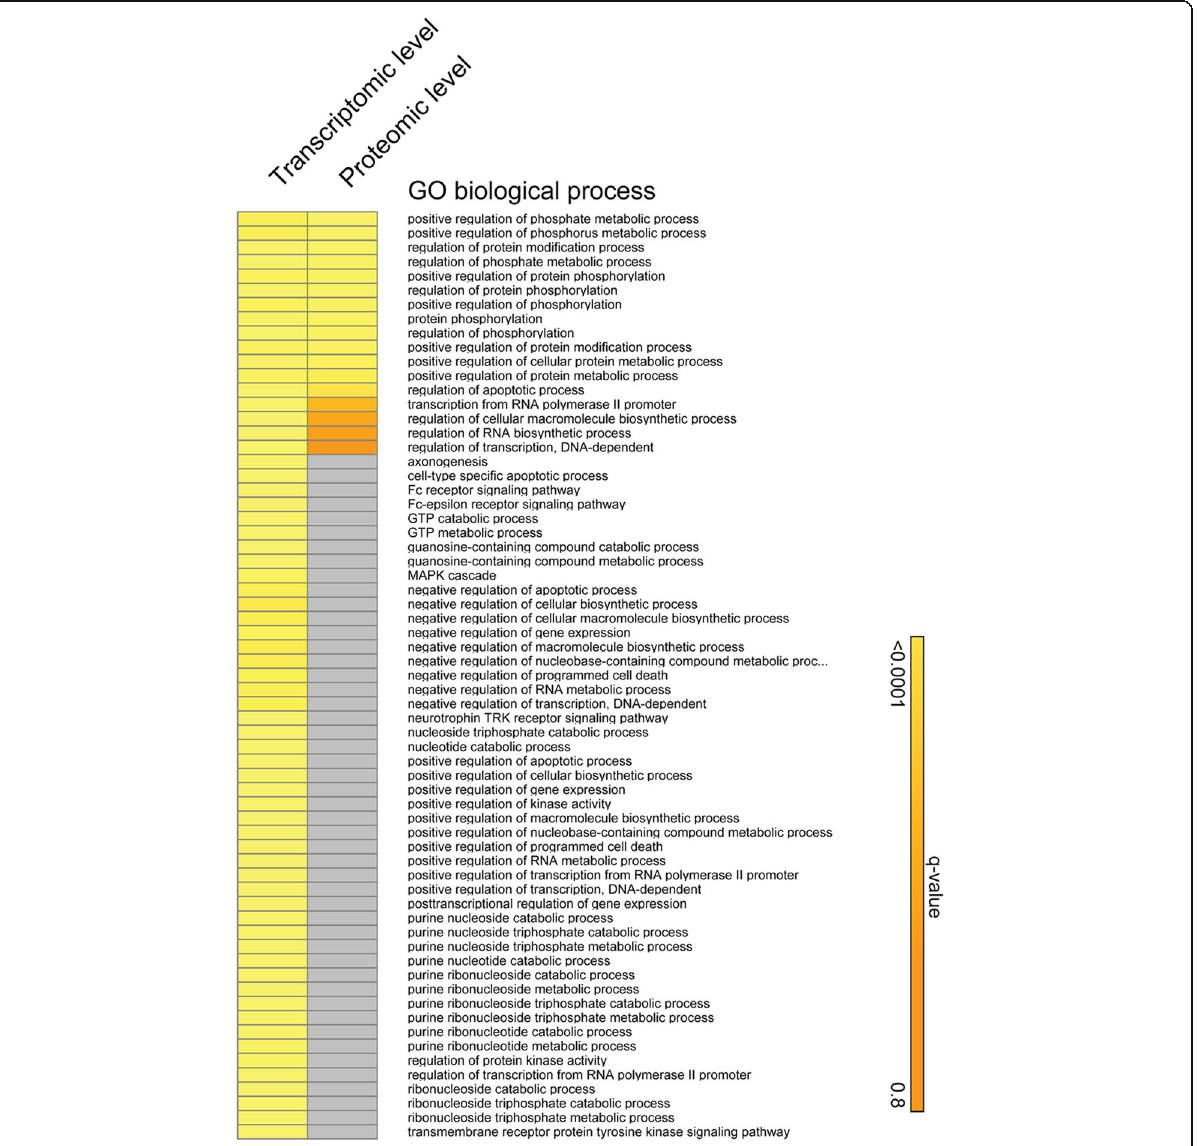
Fig. 5 Network enrichment analysis highlights the overlap between transcriptomic and proteomic data. The most regulated transcripts or proteins (fold changes > |1.5| and q-values <0.05 between cells transfected with either syndecan-1 or syndecan-1 without a nuclear localization signal) were used separately to assess GO biological processes (Funcoup 3.0). The results were diagramed with the Gene-E program. Grey cells represent missing